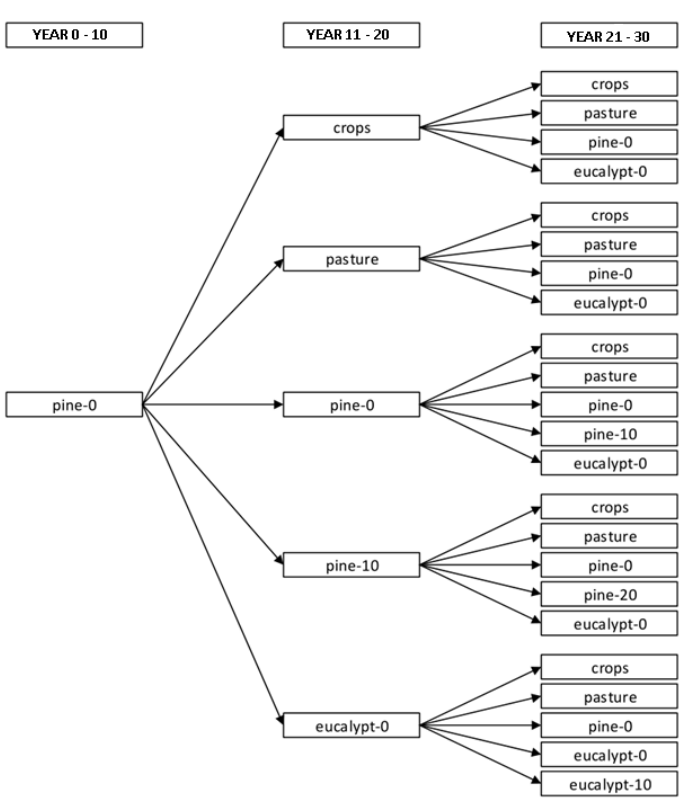
Figure 2. Tree view of all land use trajectories that start with pine forest. pine-X or eucalypt-X indicate a pine or eucalypt forest of X years of age,